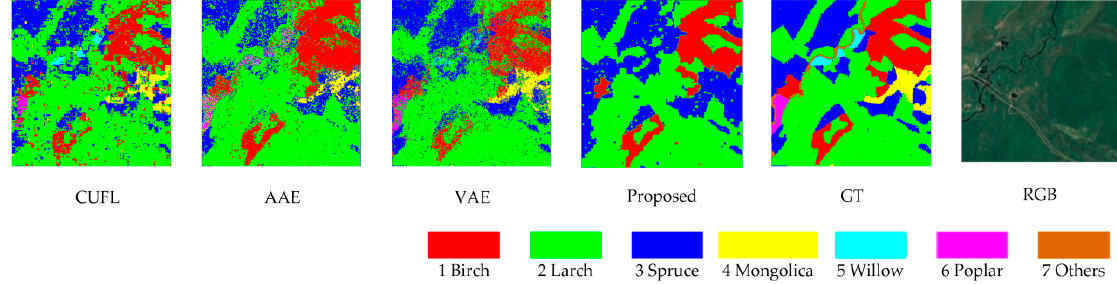
Figure 6. Tree classification maps of models for dataset (1). Table 13. The classification accuracy of models for dataset (3).